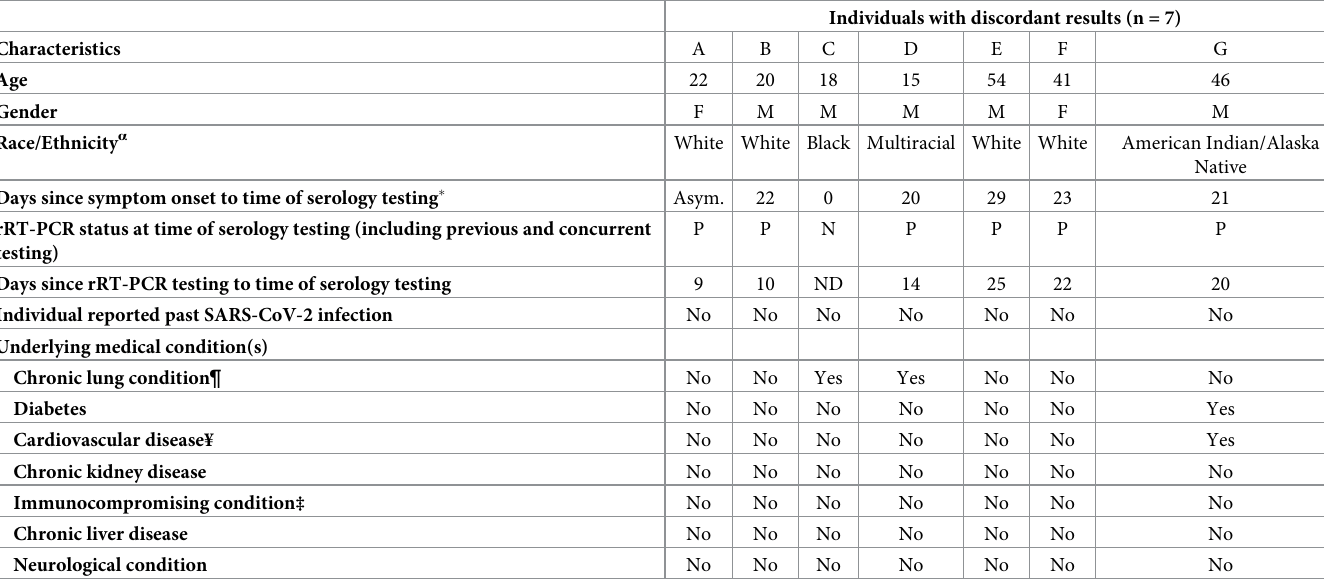
Table 2. Detailed description of individuals with discordant serology assay test results (n = 7).